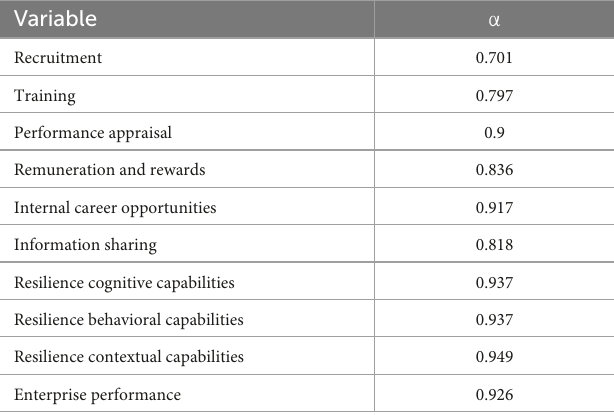
TABLE 1 Reliability analysis.